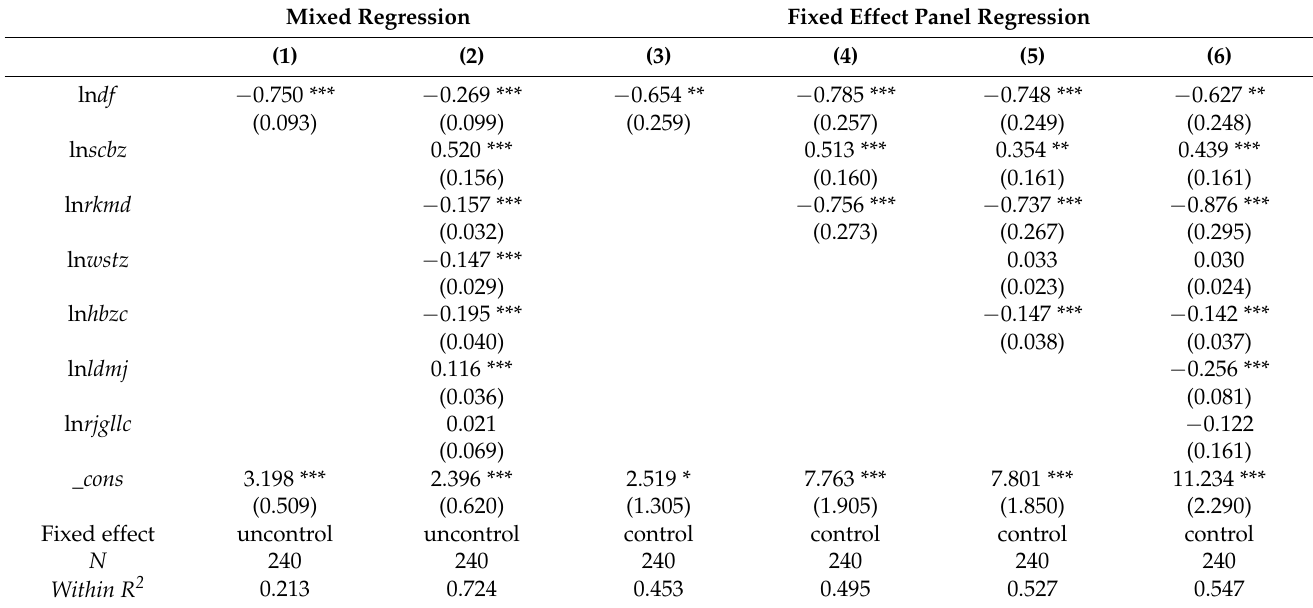
Table 1. Benchmark regression results on the impact of digital finance on green